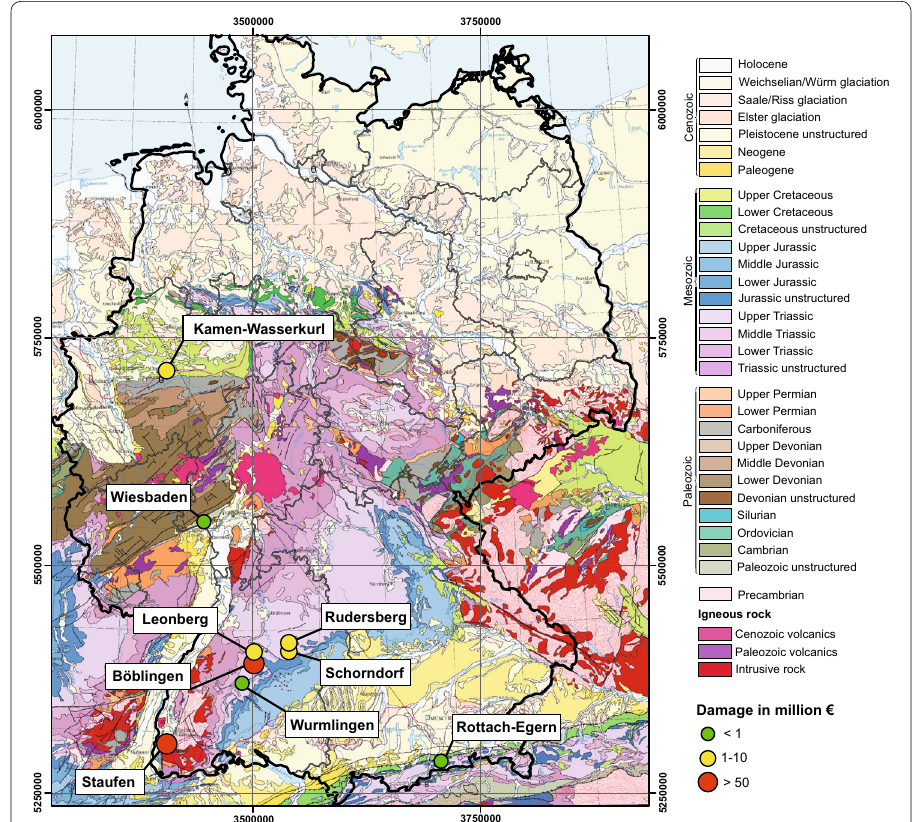
Fig. 2 Spatial distribution of vertical GSHP damage events in Germany including a geological